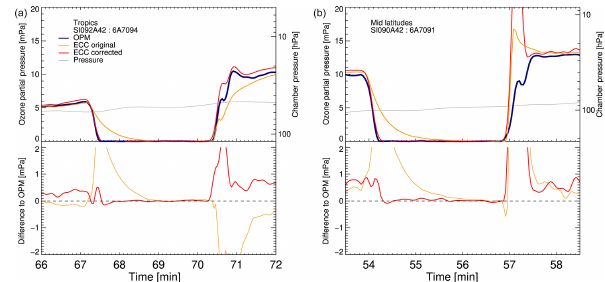
Figure 4. Cell current components of the tropical and midlatitude simulations shown in Fig. 3. Red lines: corrected cell current. Blue lines: fast-reaction contribution. Purple lines: slow-reaction contri- bution. Orange lines: originally measured cell current minus con- stant background. Light blue lines: constant background.